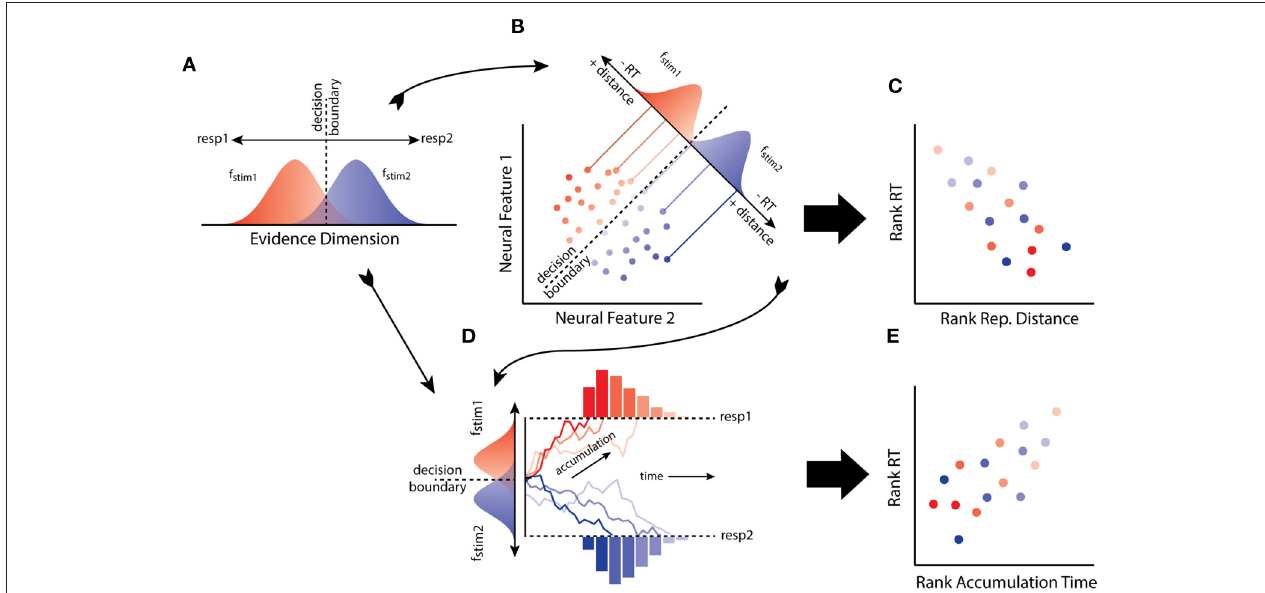
FIGURE 1 | (A) The model of the observer from signal detection theory (SDT) maps to (B) the distributions of patterns of neural activity as reconstructed using neural decoding. (C) From this connection it is predicted that RT will negatively correlate with distance from a decision boundary through activation space. (D) The model of the observer from SDT, and the distributed patterns of neural activity, can also be linked to the evidence accumulation process. (E) Thus another prediction from the hypothesis is that distances from a decision boundary in activation space reflects the mean accumulation rate, and hence RT should correlate with accumulation rates determined by representational